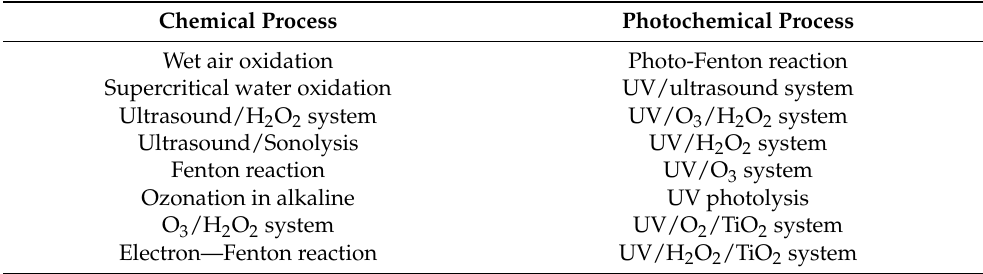
Table 1. Types of advanced oxidation processes; adapted from [19,46].